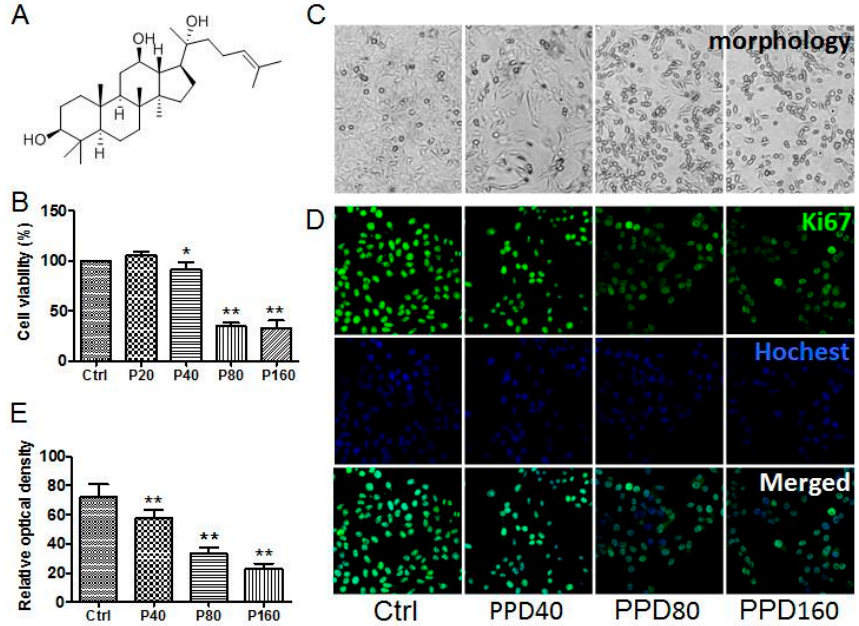
Figure 1. Inhibitory effect of 20( S )-Protopanaxadiol (PPD) on the proliferation of Hep-2 cells. ( A ) The chemical structure of PPD; ( B ) MTT assay measured the viability of Hep-2 cells treated with different concentrations of PPD for 24 h. Data are expressed as mean ± S.D . , * p < 0.05, ** p < 0.01, for PPD-treated cells vs. DMSO (Dimethyl Sulphoxide)-treated cells, n = 6; ( C ) Morphological images of Hep-2 cells in the presence of treatment as illustrated; ( D ) Confocal images of Ki67 and nucleus in Hep-2 cells with or without PPD treatment to detect cell proliferation. Ki67 was labeled with primary antibody and Alexa Fluor 488-conjugated goat anti-mouse IgG. Nuclei were stained with Hoechst; ( E ) The relative optical density of Ki67, which presents the ability of cell proliferation. Data are expressed as mean ± S.D., ** p < 0.01, compared to control, n =